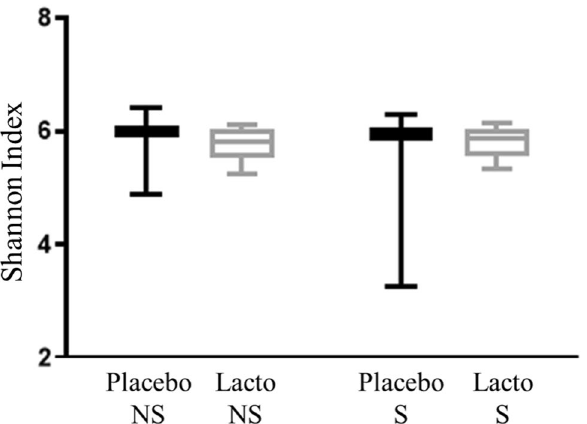
Figure 3. Beta diversity of microbial community diversity of cecal samples from laying hens. Beta diversity analysis as shown by Bray–Curtis distance calculations. The dissimilarity values for each experimental group based on supplementation (Lacto: L. rhamnosus , Placebo: Placebo supplementation) and stress (S: stressed, NS: non-stressed) treatment compare week 18 (baseline) and week 27 (n: S-Placebo = 22, NS-Placebo = 22, S-Lacto = 18, NS-Lacto = 22). Asterisks (*) indicate statistically significant differences (P < 0.05).